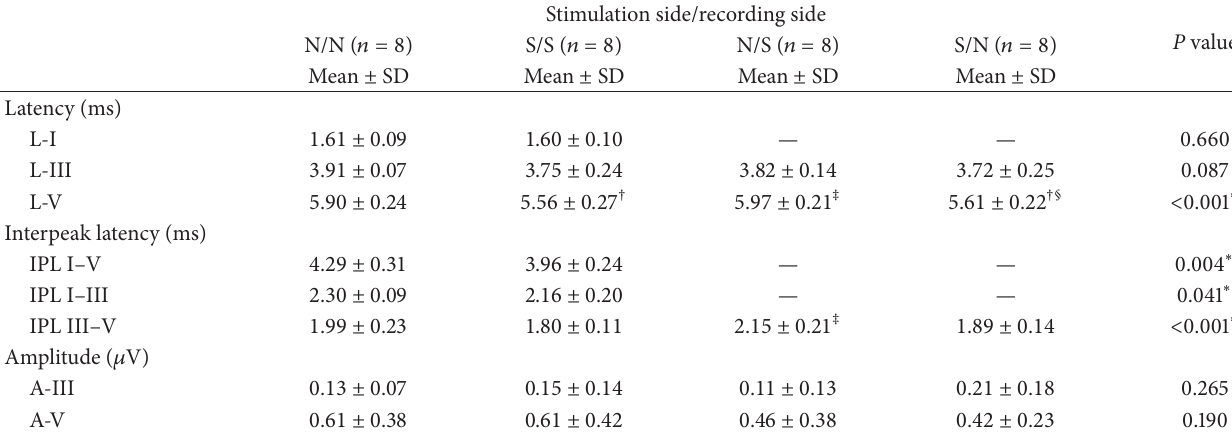
Table 3: Absolute latency, interpeak latency, and wave amplitude in hemispherectomized